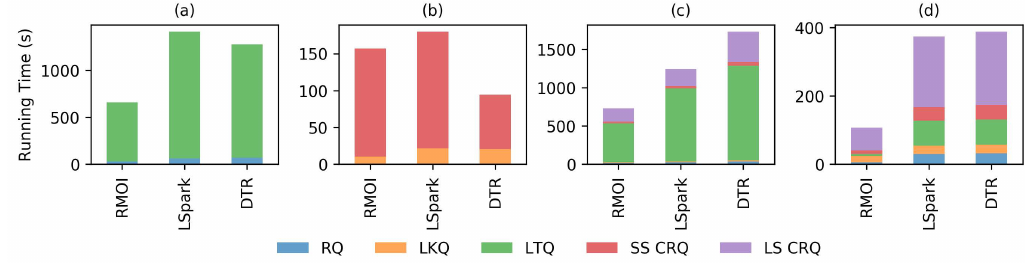
Figure 13. Stress testing on the UK + IE dataset with low resource availability on ( a ) 1st query set with 2 QTs, ( b ) 2nd query set with 2 QTs, ( c ) 3rd query set with 5 QTs, and ( d ) 4th query set with 5